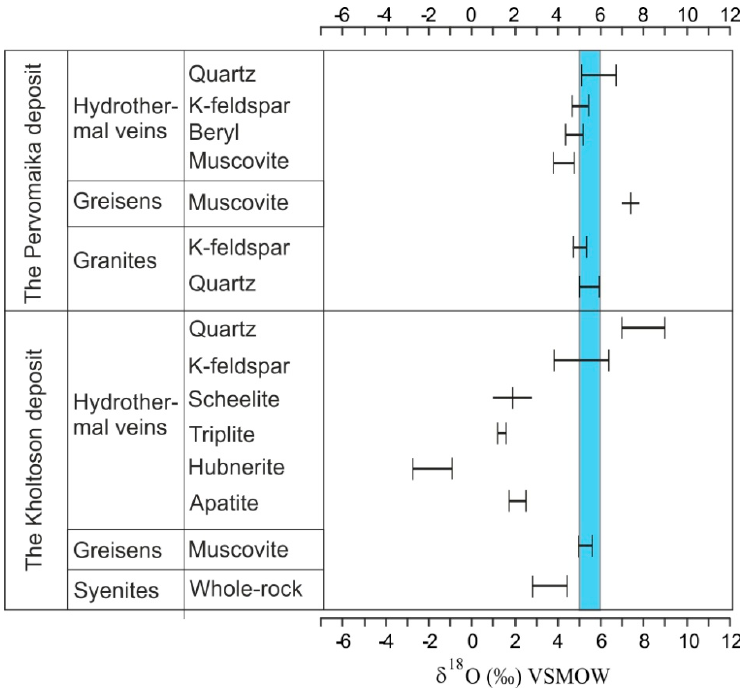
Figure 5. The δ 18 O values in minerals from the Pervomaika and the Kholtoson deposits. The blue field within 5–6‰ δ 18 O corresponds to the mantle oxygen values.